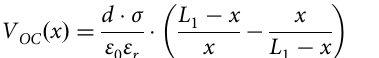
where L 1 represents the electrode width, L 2 the electrode gap (considering that the value of L 2 is negligible compared to that of L 1 , L 2 can be ignored), d the dielectric material ’ s thickness, σ the tribocharge density, ε 0 vacuum permittivity, ε r the dielectric material ’ s relative permittivity, x the displacement of the